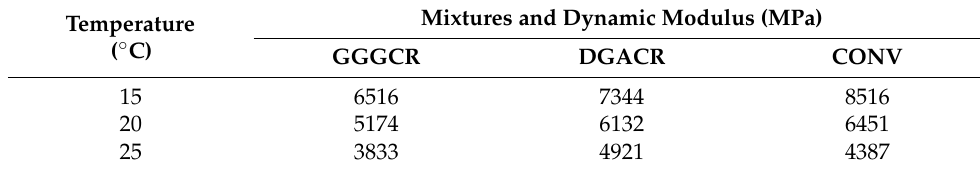
Table 2. Dynamic modulus of the mixtures (20 ◦ C, 10 Hz).